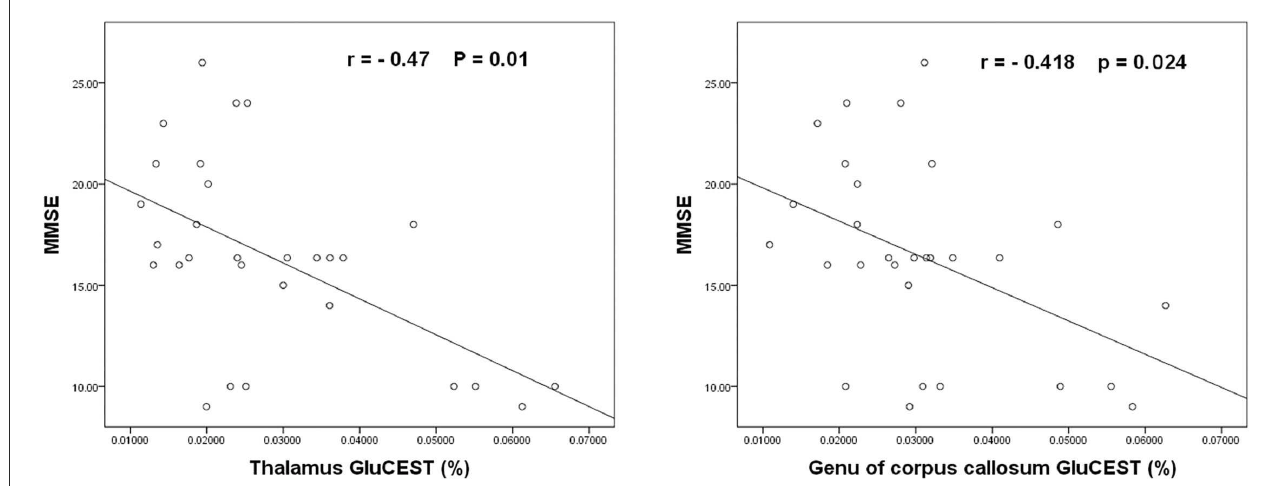
FIGURE3 The negative association of the GluCEST% in the thalamus and the genu of the corpus callosum with the MMSE scores of patients with CO